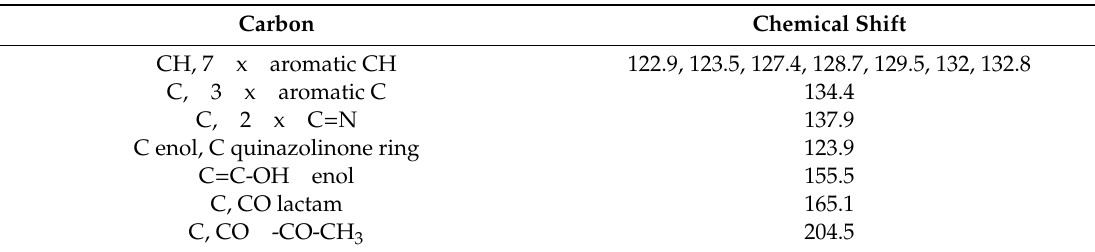
Table 3. 13 C-NMR chemical shifts for compound 3 in DMSO- d 6 .